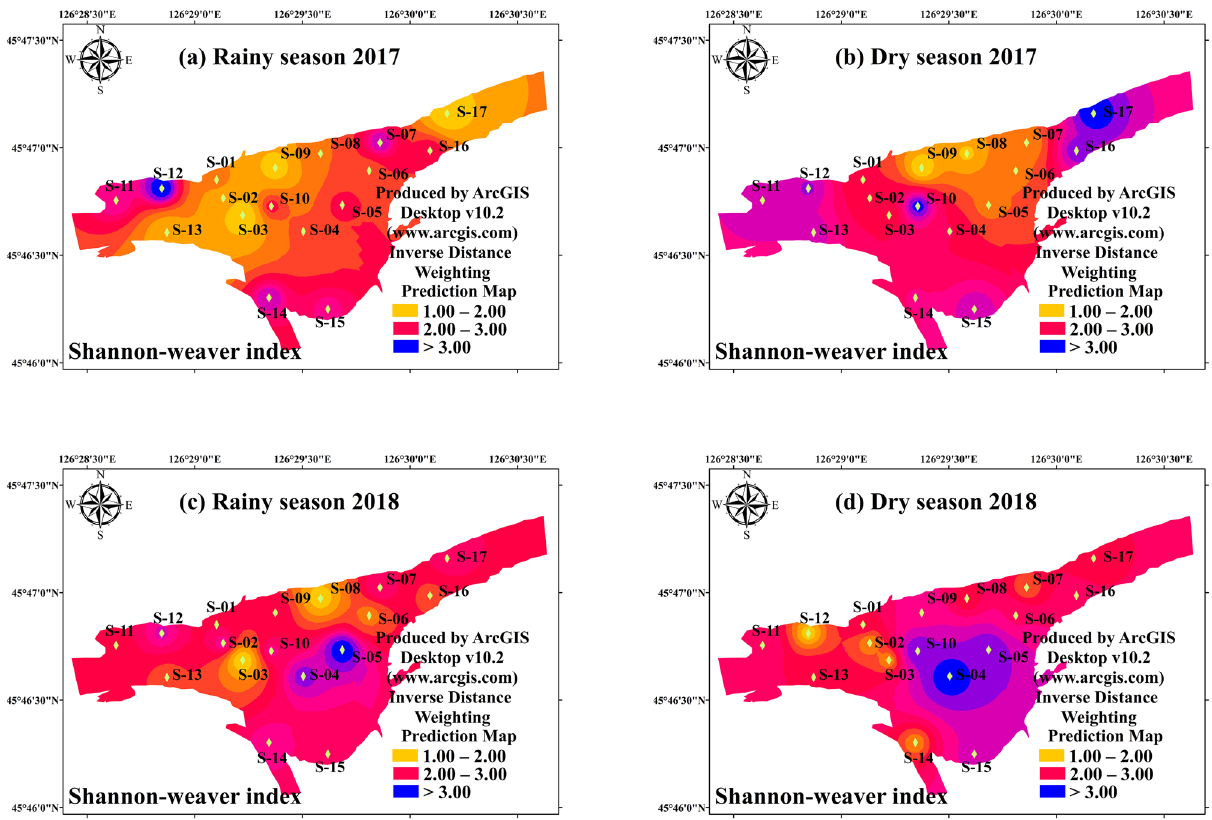
Figure 5. The spatial distribution of phytoplankton Shannon–Weaver index in study period. ( a ) Rainy season (July 2017); ( b ) Dry season (October 2017); ( c ) Rainy season (July 2018); ( d ) Dry season (October 2018). The interpolation map was constructed by ArcGIS software using the Inverse Distance Weighting method. The maps were created using software ArcGIS Desktop v10.2 (www.arcgi